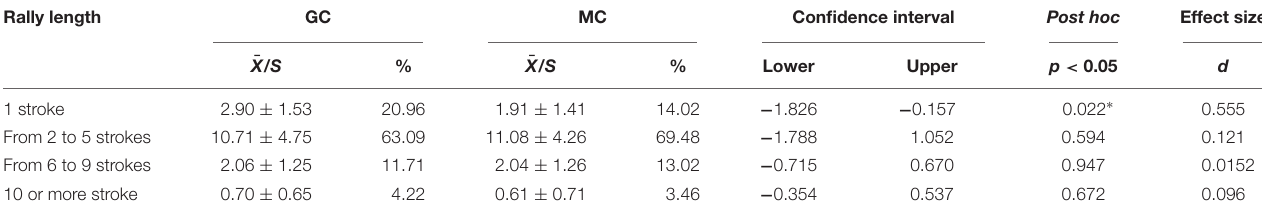
TABLE 5 | Descriptive values (mean, standard deviation, and percentage) and analysis of variance (Student’s t -test for paired samples) of the “length rally” per match. Rally length GC MC Confidence interval Post hoc Effect size